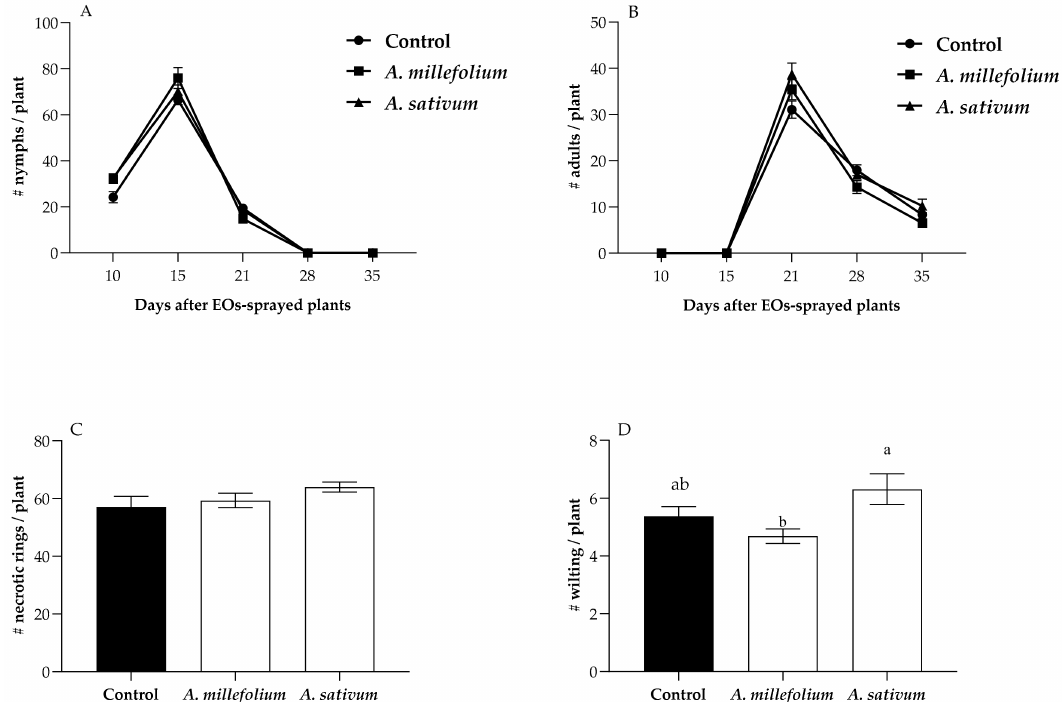
Figure 5. Performance of Nesidiocoris tenuis on plants previously treated with Achillea millefolium or Allium sativum essential oils. ( A ) Number (mean ± SE) of nymphs per plant; ( B ) Number (mean ± SE) of adults per plant; ( C ) Number (mean ± SE) of necrotic rings per plant; ( D ) Number (mean ± SE) of wilted plants. Tukey’s multiple range test determined the significance between treatments at p ≤ 0.05. Different lower-case letters are significantly